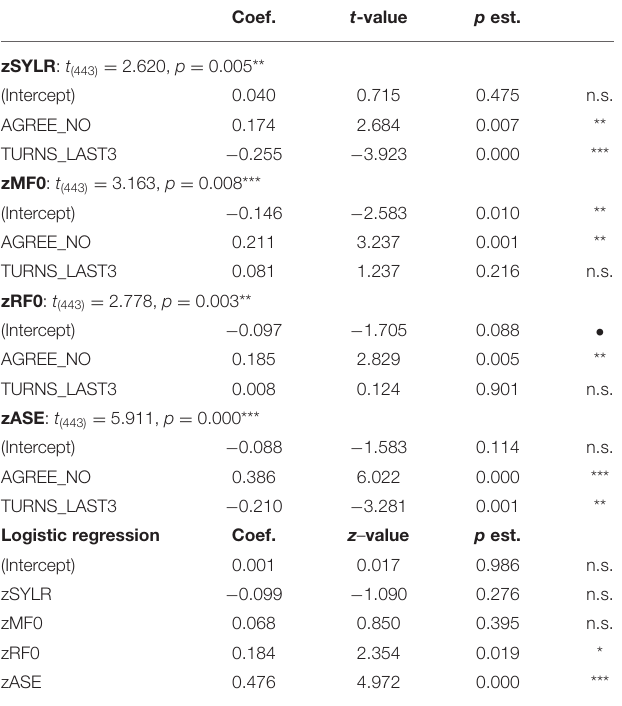
TABLE 2 | Linear Mixed-effects Model (LMM) results for audio behavioral measures. Coef. t